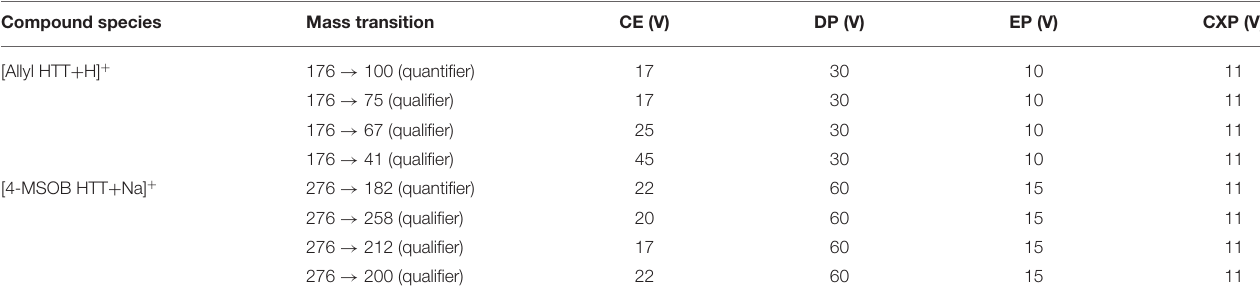
TABLE 1 | Mass transition parameters for determination of 3-allyl-4-hydroxythiazolidine-2-thione (allyl HTT) and 4-hydroxy-3-(4-(methylsulfinyl)butyl)thiazolidine-2-thione (4-MSOB HTT) by LC-MS/MS. Compound